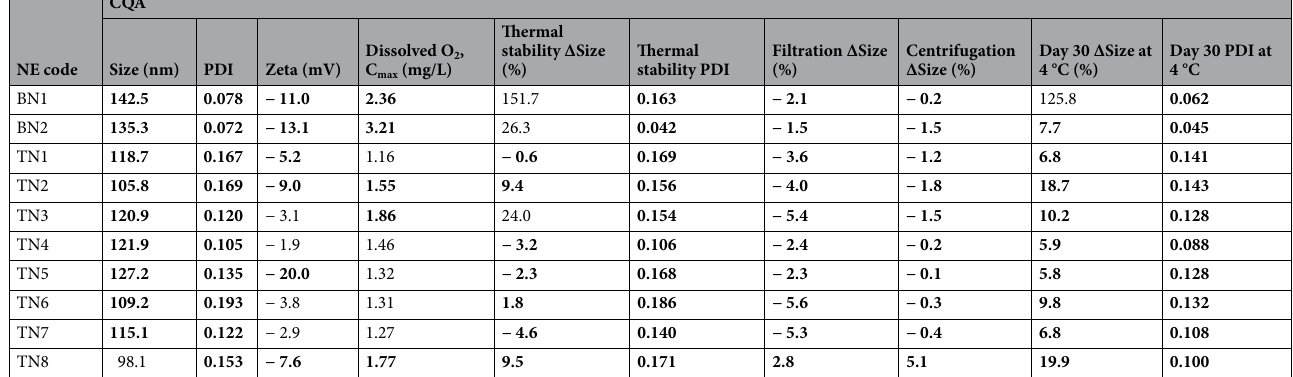
Table 3. Evaluation of critical quality attributes (CQAs). Cells with bolded font meet the CQA specifications. NE nanoemulsion, BN biphasic nanoemulsion, TN triphasic nanoemulsion, PDI polydispersity index; C max , maximum dissolved O 2